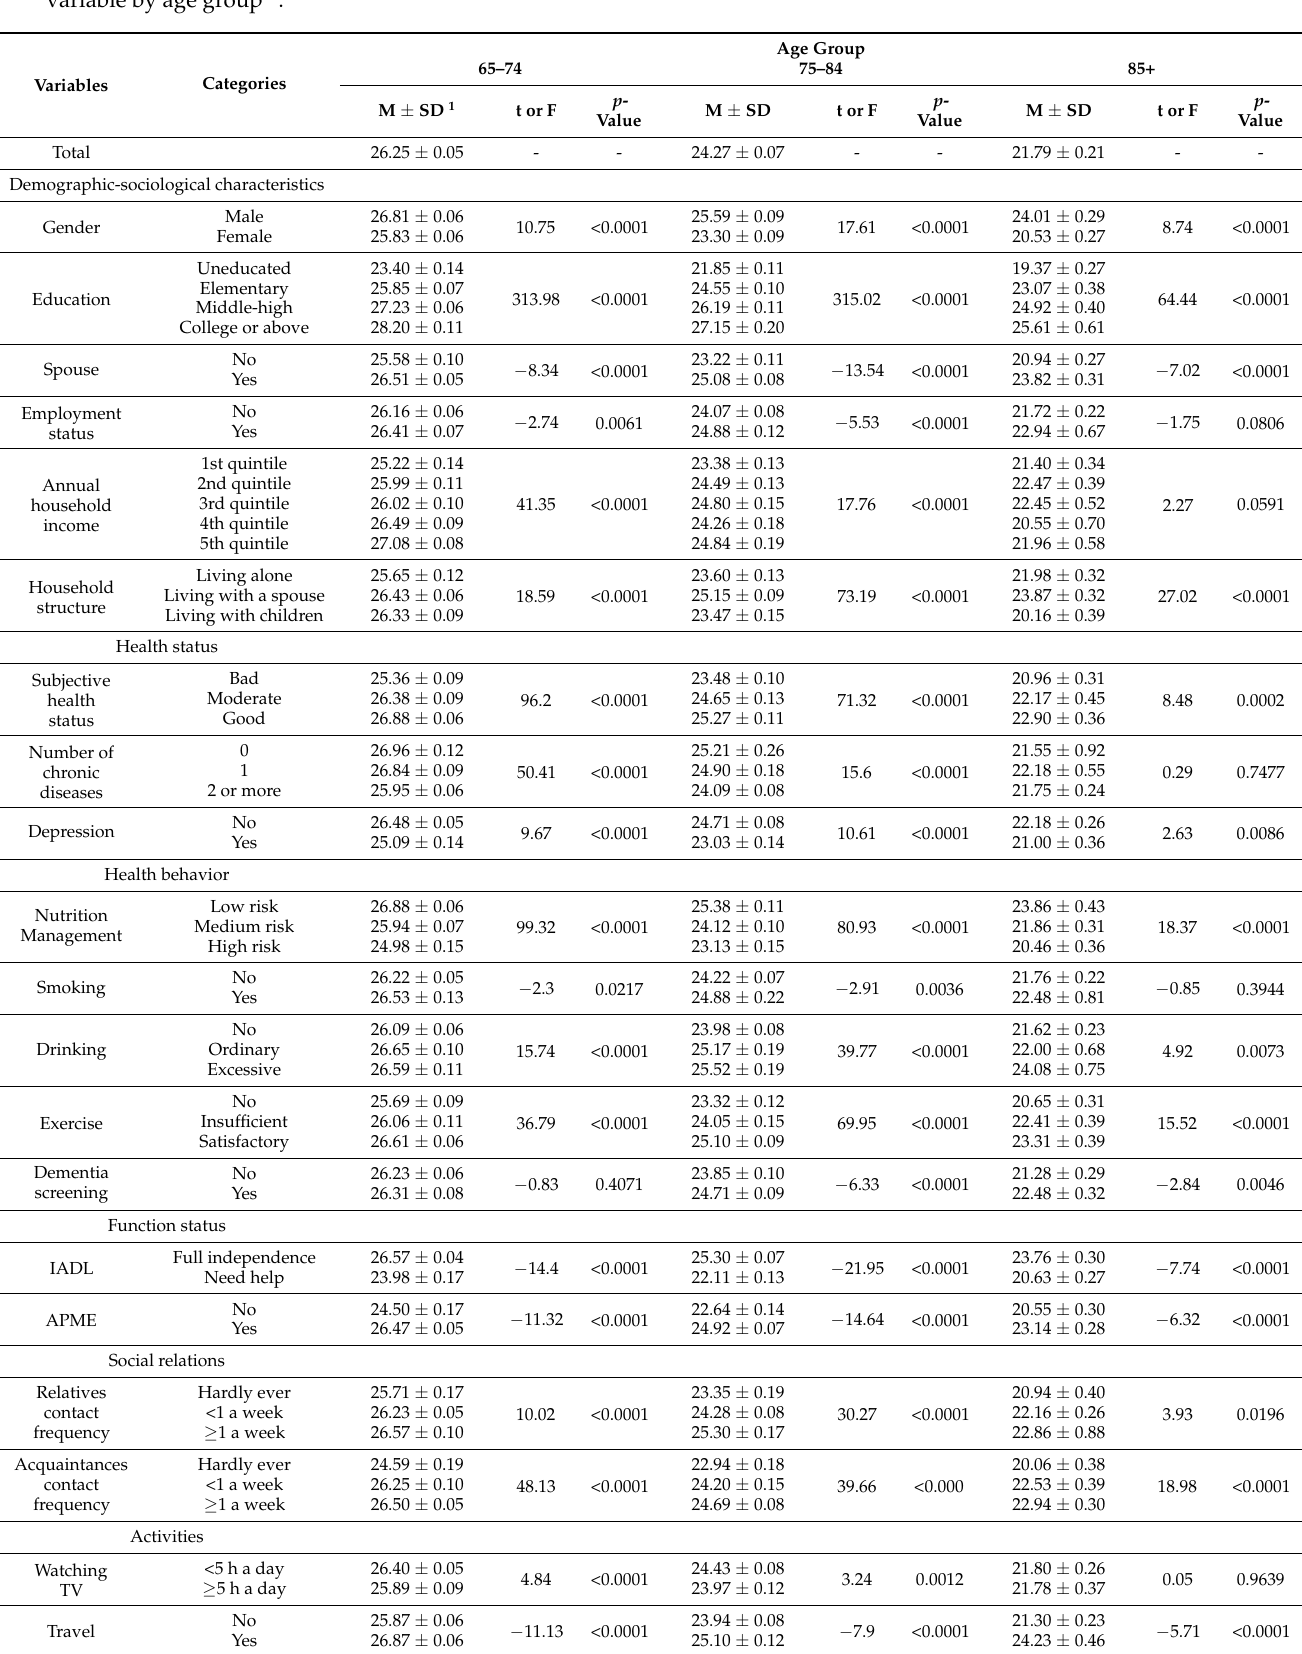
Table 2. Mean and standard deviation of MMSE and significance test of mean difference in MMSE among categories of each variable by age group 1